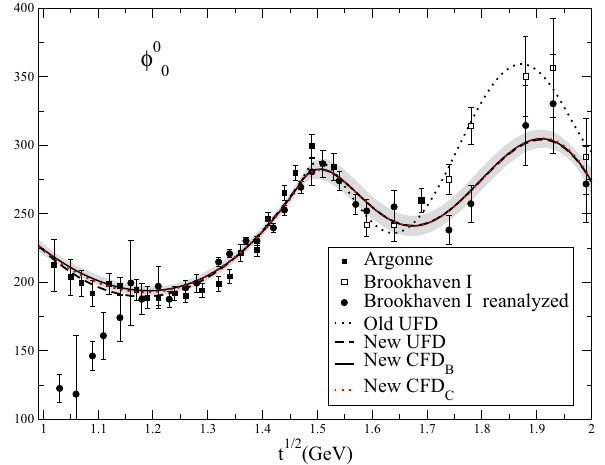
Fig. 18 New CFD φ 0 by using our model for the g 0